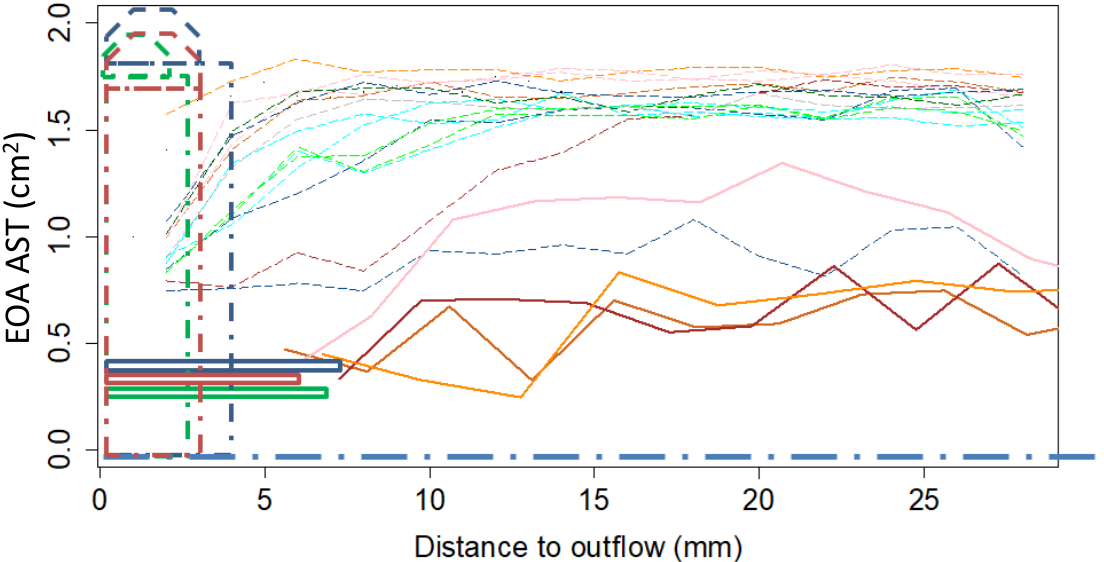
Figure 5. Numerical and MRI results — EOA computation as function of the distance from BMHV outflow for numerical analysis (dashed lines) and MRI results (continuous lines). The representation of the BMHV profile (dotted dashed line) is for representation only. Narrow horizontal boxes represent the location of the leaflets for each BMHV profile (dark blue: OnX prosthesis, green: SJM23, and red: SJM25).